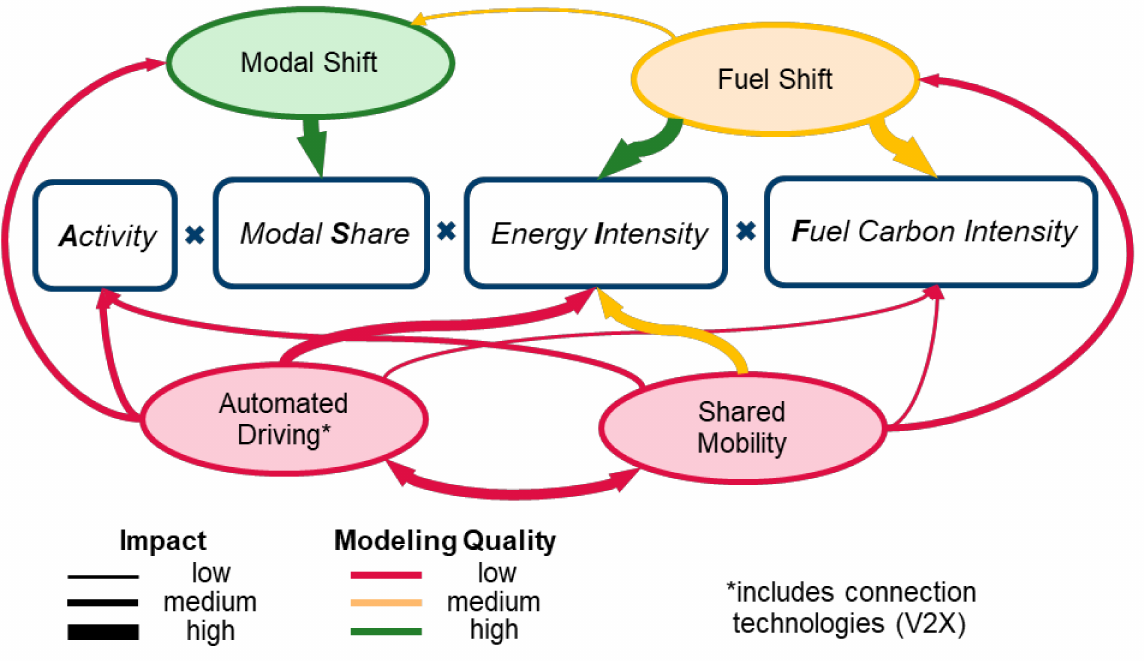
Figure 10. Impact of mobility trends on each other and parts of ASIF, as well as their modeling quality in transport sector models. * is defined in the figure as further